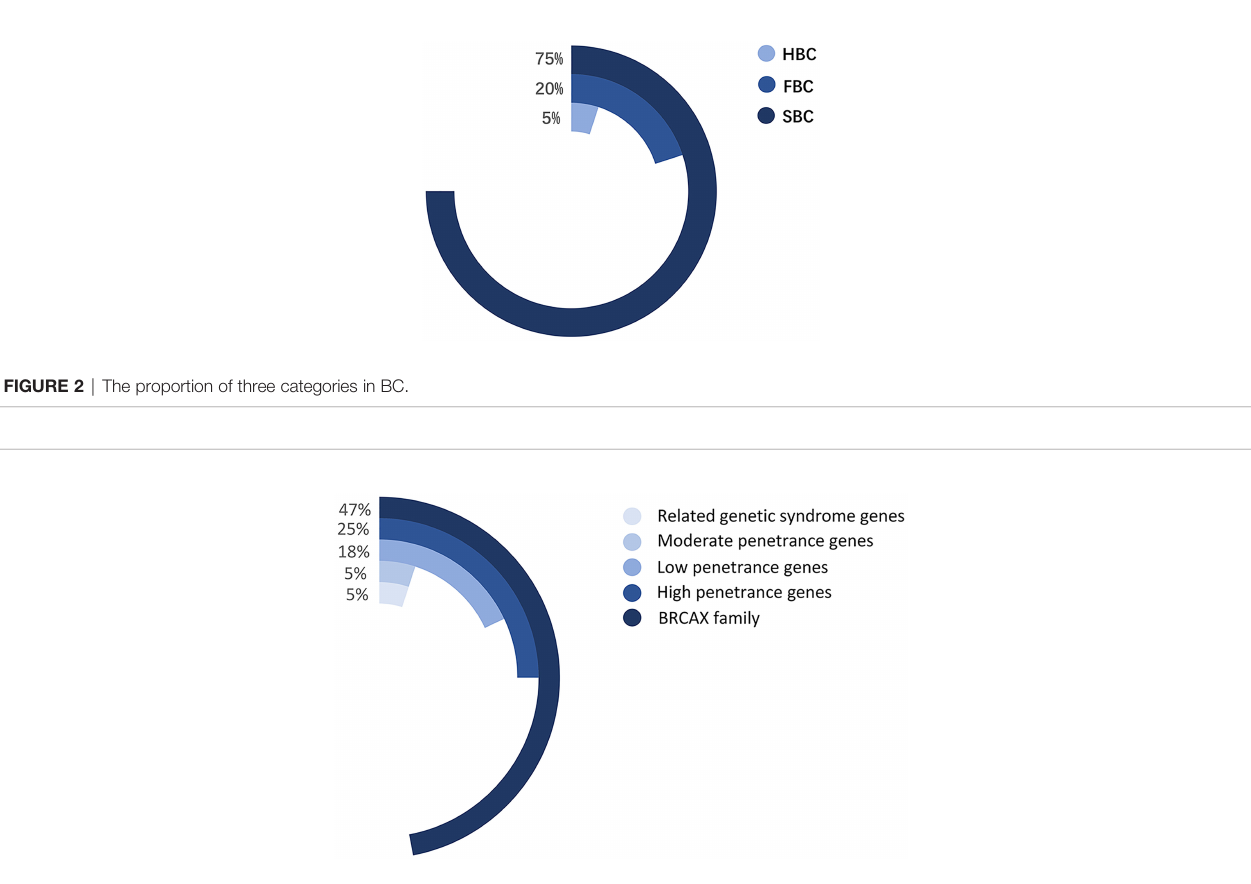
FIGURE 3 | The proportion of various gene mutations in FBCs. Related genetic syndrome genes refer to mutated genes found in genetic syndromes related to BC, such as HBOC. Related genetic syndrome genes accounts for about 5% of whole mutation genes. Low-, moderate-, and high- penetrance genes are classi fi ed as BC mutation genes based on lifetime risk of disease. The BRCAX family accounted for the largest proportion, reaching 47% of whole mutation genes. Patients belong to The BRCAX family have not found any currently known disease-causing mutation genes.